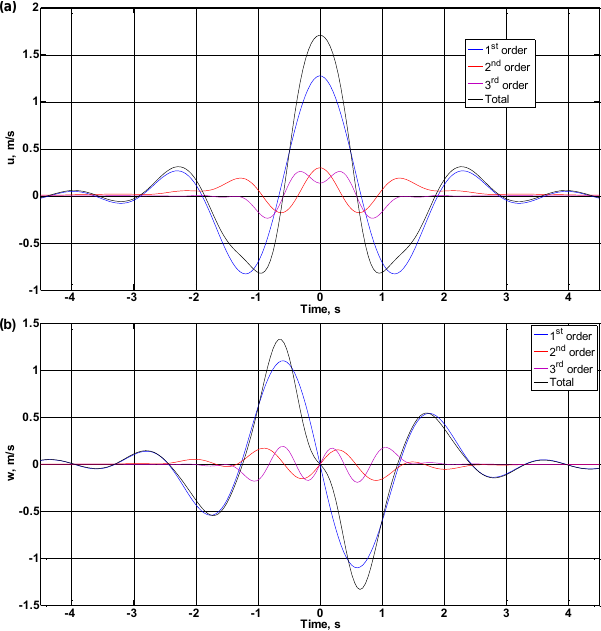
Fig. 2. Surface velocity at the focusing location for ε = 0 . 3 and T 0 = 2 . 8s: (a) horizontal component u ; (b) vertical component w .